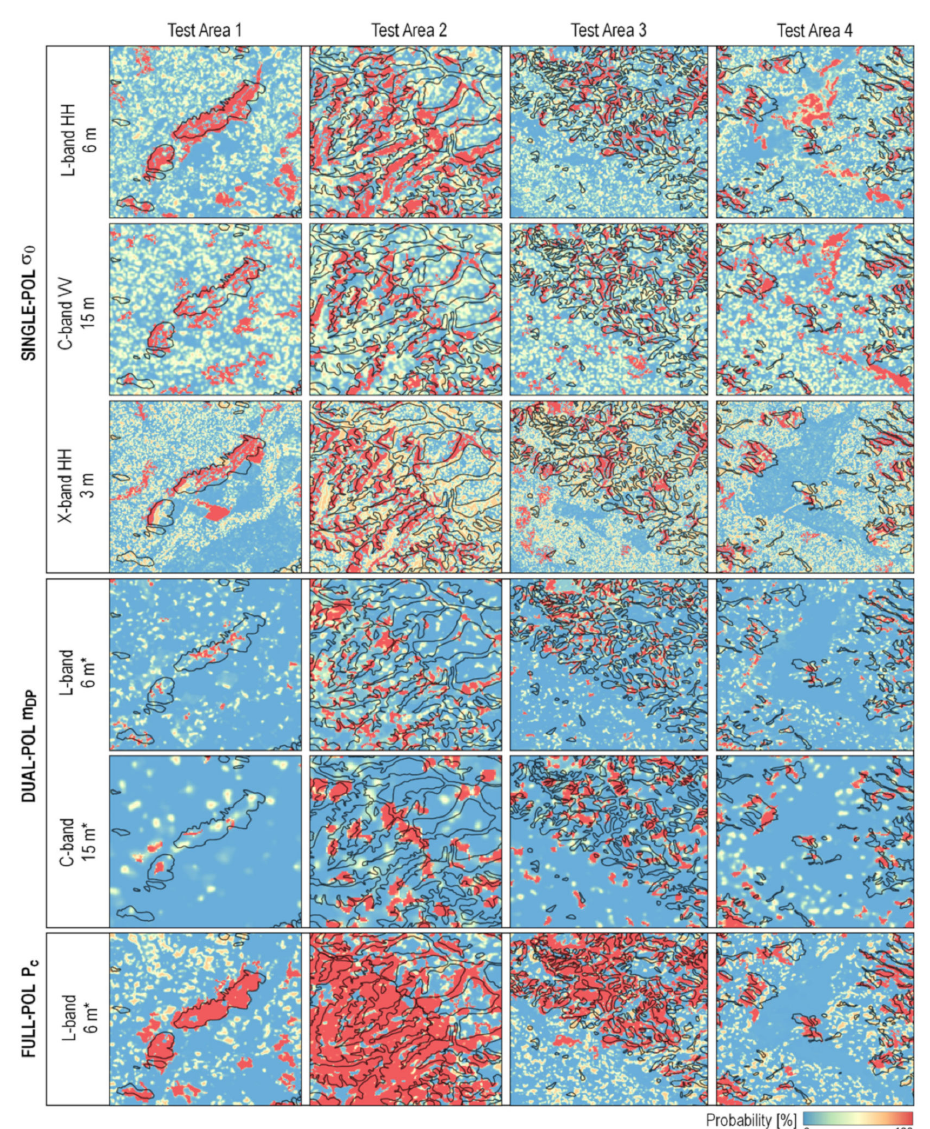
Figure 6. Bayesian probability maps obtained from different datatypes in the Hokkaido landslide case. The asterisk (*) indicates the image is processed by taking spatial ensemble averaging using a 5 × 5